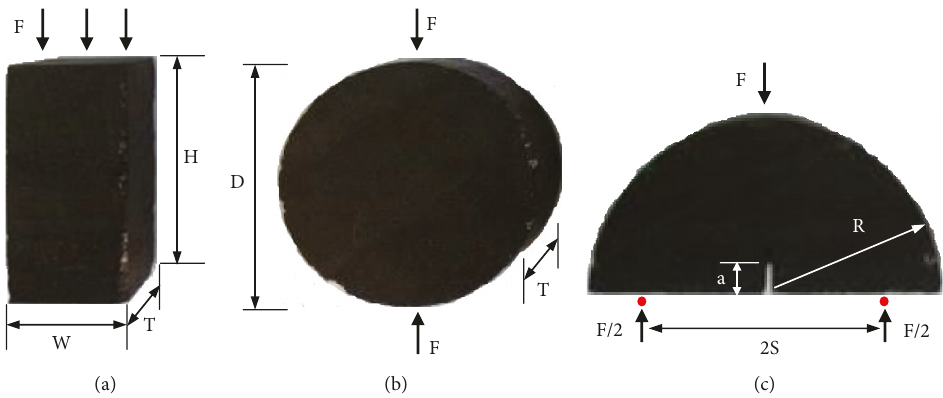
Figure 5: Optical deformation measurement device (a) UC testing, (b) BD testing, and (c) NSCB testing.